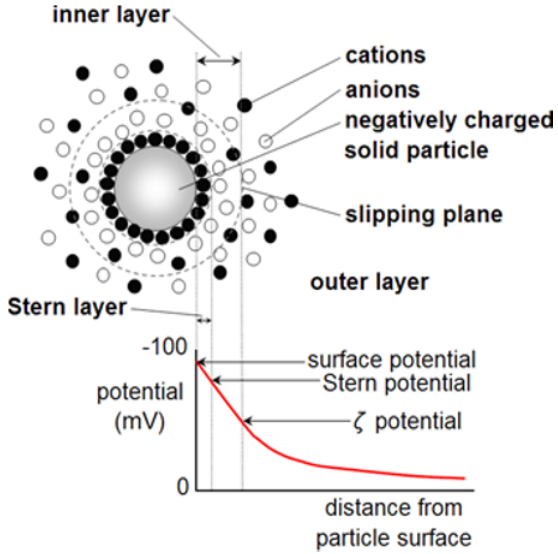
Figure 2. Electrokinetic ( ζ ) potential of negatively charged solid particle in dispersion